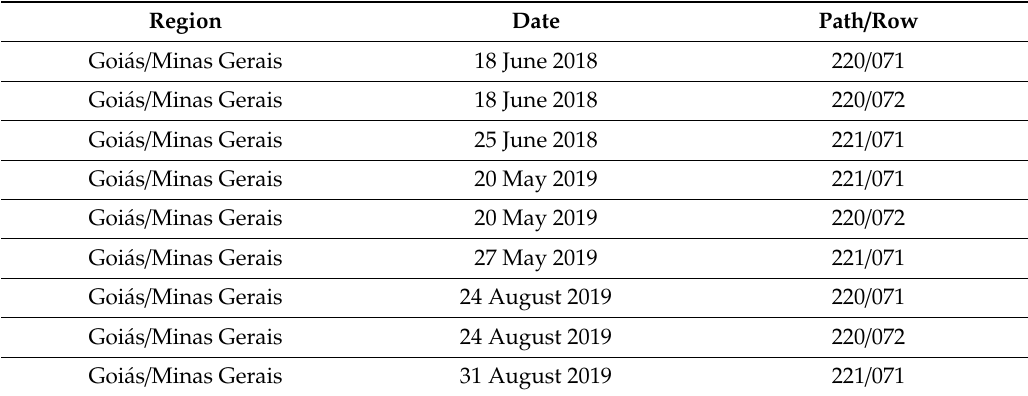
Table 2. Landsat-8 OLI Operational Terra Imager images used to analyze di ff erent season behaviors.